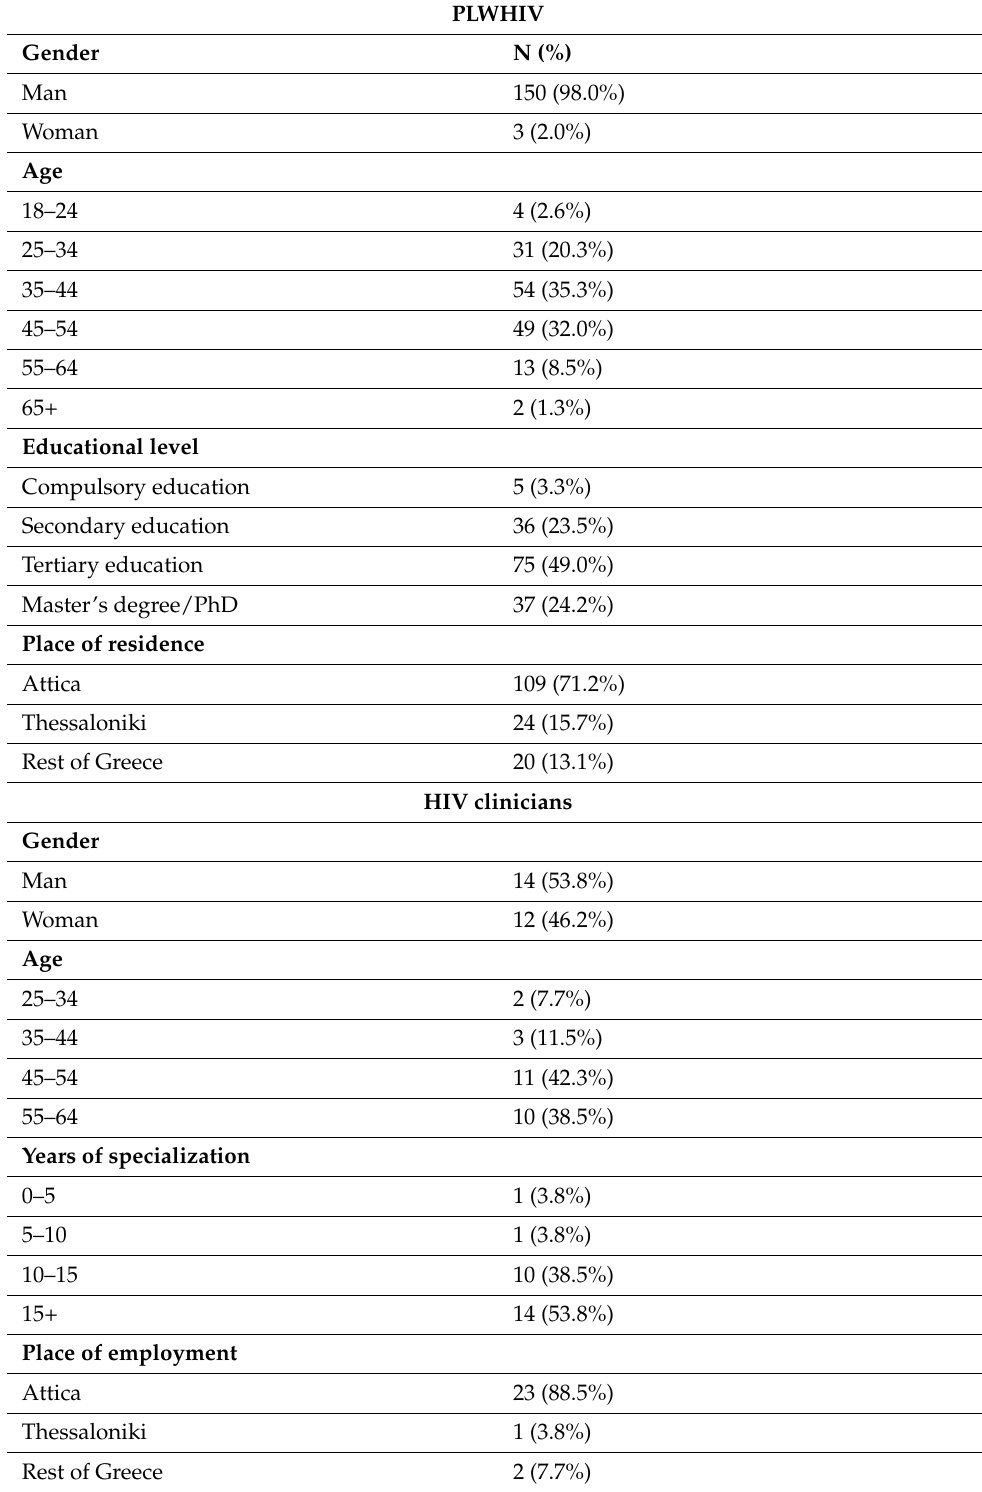
Table 1. Socio-demographic characteristics of the